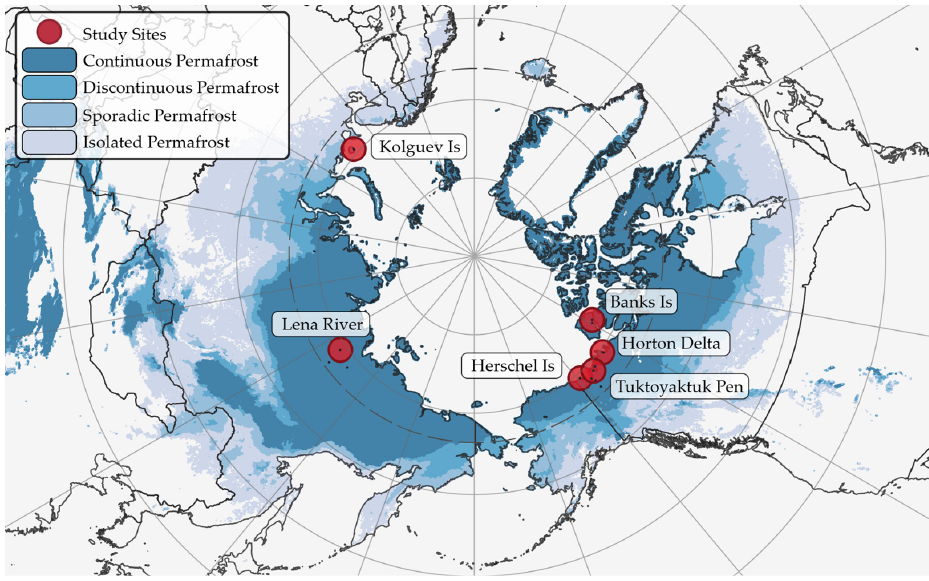
Figure 1. Overview map of study sites and permafrost extent based on (Obu et al., 2018).